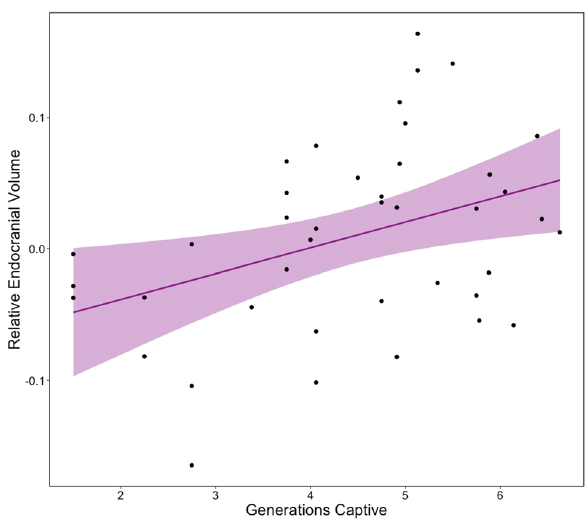
Figure 1. Linear regression of relative endocranial volume (allometrically corrected residuals of endocranial volume relative to skull length) across captive generations, showing a clear trend of increasing volume with subsequent generations (r 2 = 0.13, F = 6.90, p = 0.01*). Points denote individual specimens; the shaded region represents a 95% confidence interval. P -value significance: 0.01–0.05*, 0.001–0.01**,